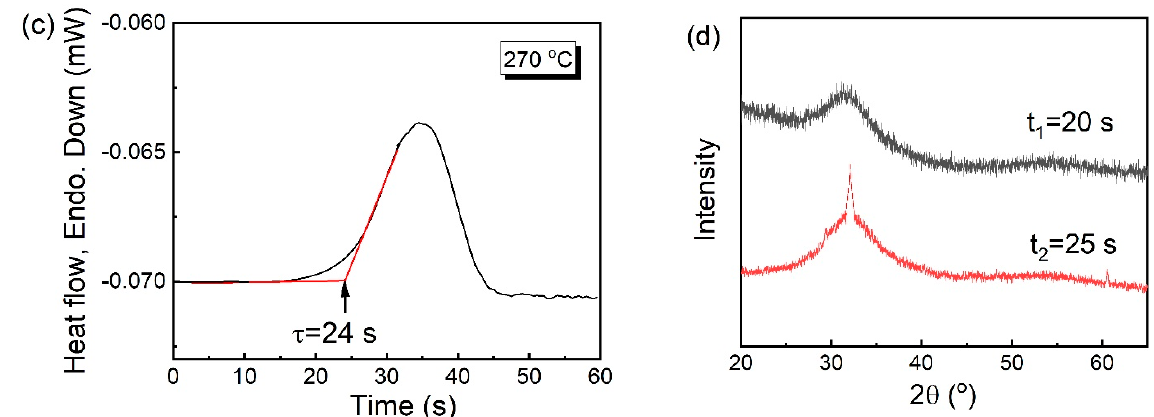
Figure 4. ( a ) A series of Flash DSC heat flow curves corresponding to different annealing times ranging t a from 1 to 50 s at 270 °C for La 60 Ni 15 Al 25 MG; ( b ) plot of T g and t a at 270 °C ( t 1 and t 2 are two selected annealing times before and after the break point of 22.5 s); ( c ) the isothermal test for La 60 Ni 15 Al 25 MG at 270 °C; and ( d ) XRD patterns for annealed samples corresponding to the annealing times of t 1 and t 2 .